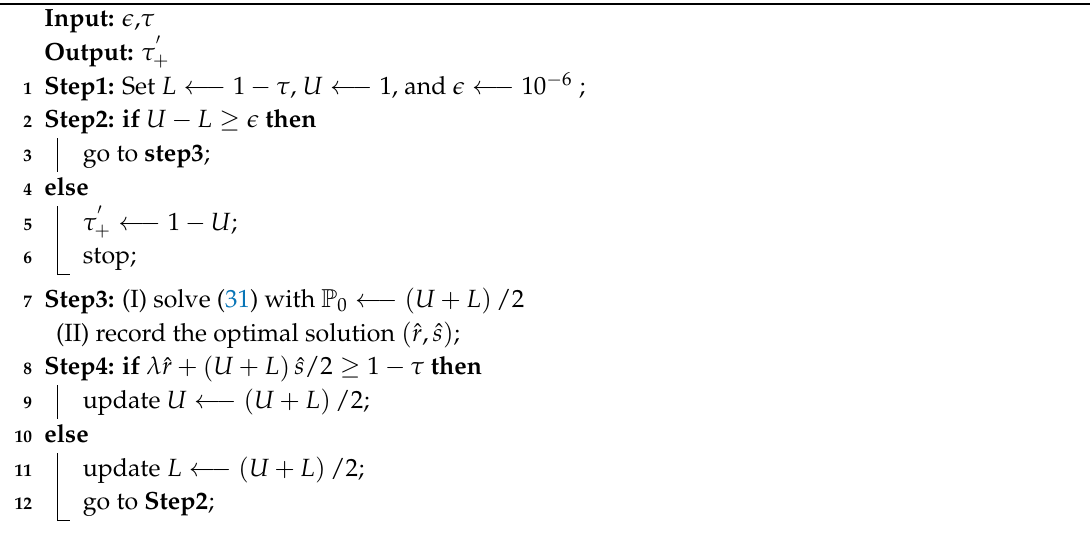
Algorithm 1: Bisection line search algorithm for τ